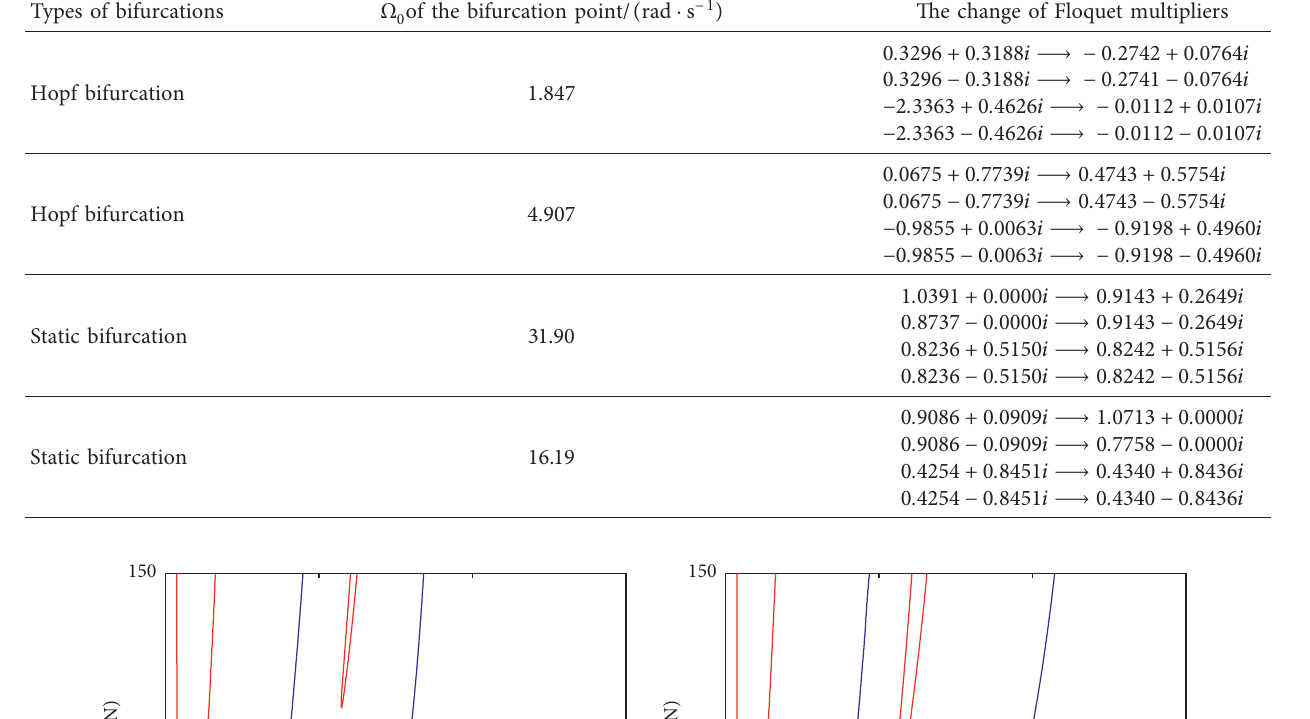
Table 1: The type of bifurcation corresponding to Figures 3 and 4 and the change of Floquet multipliers. Types of bifurcations The change of Floquet multipliers